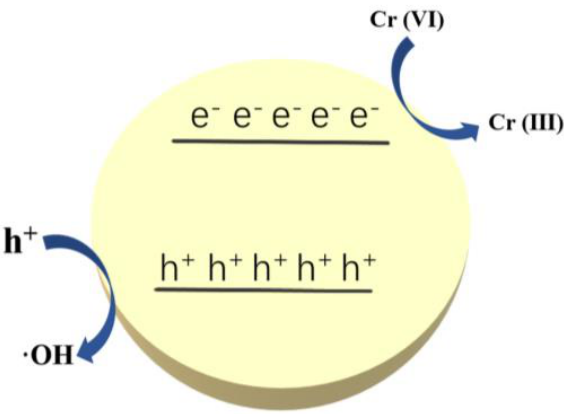
Figure 7. The mechanism of photocatalytic CA-g-C 3 N 4 removal of Cr( Ⅵ ).